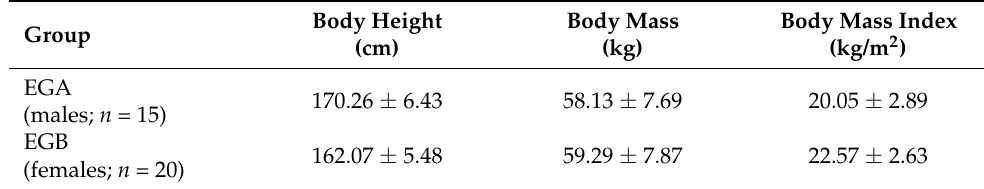
Table 1. Anthropometric characteristics of the participants (mean ± SD). Body Height Group